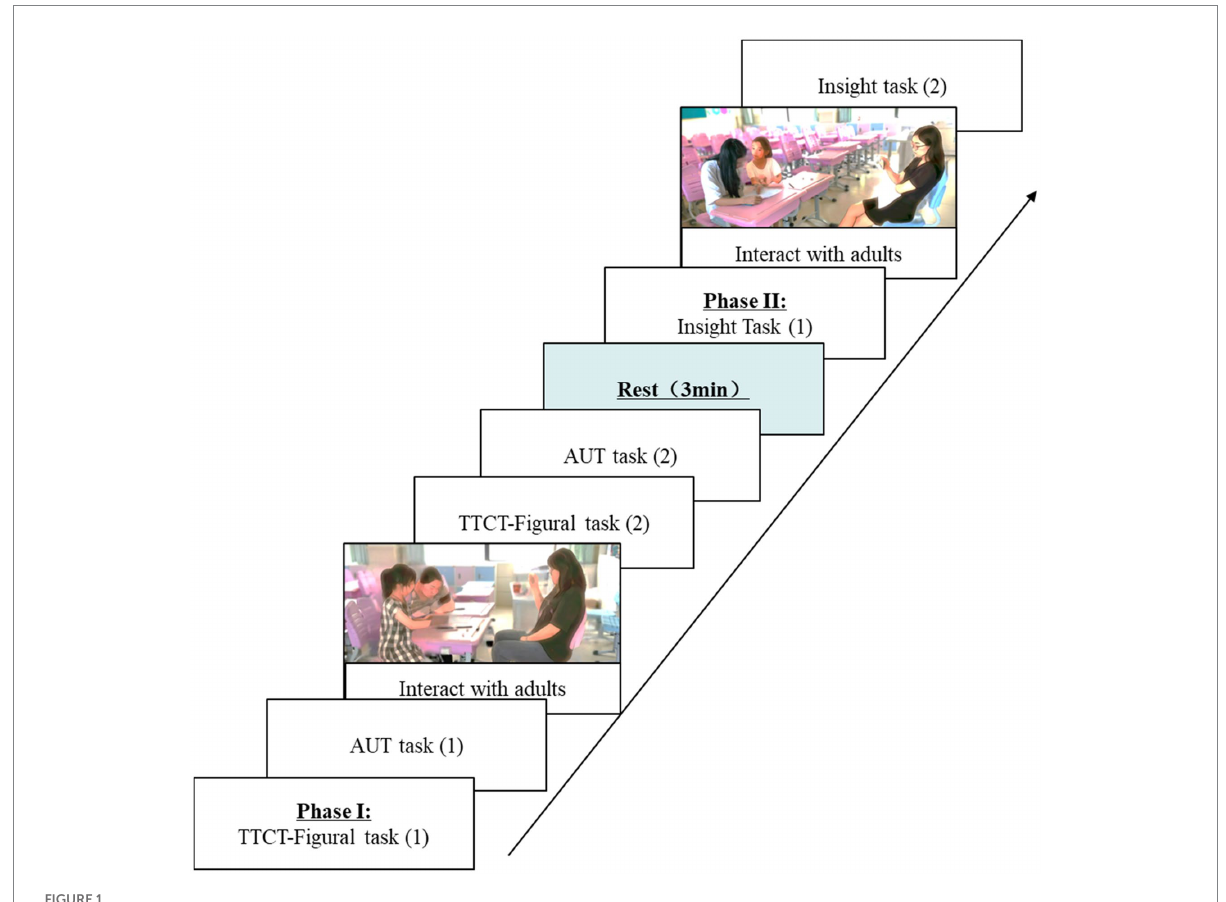
FIGURE 1 A single complete experimental procedure (one child, single experiment).